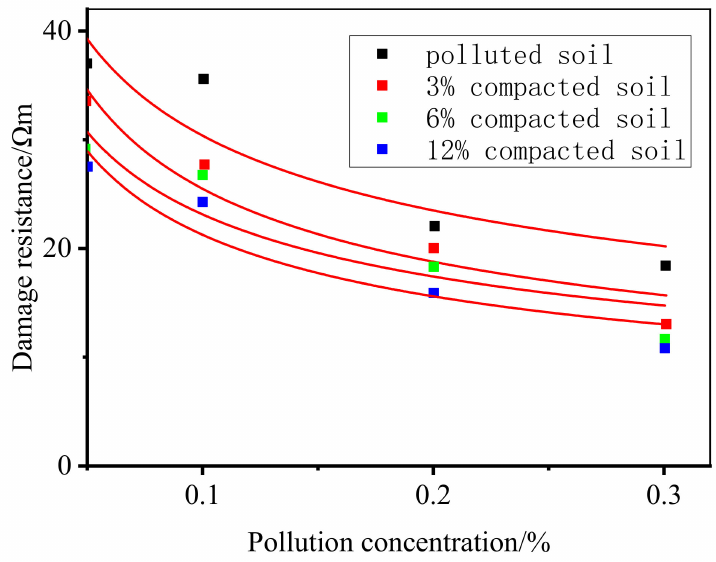
Figure 8. Damage resistivity-pollution concentration relationship